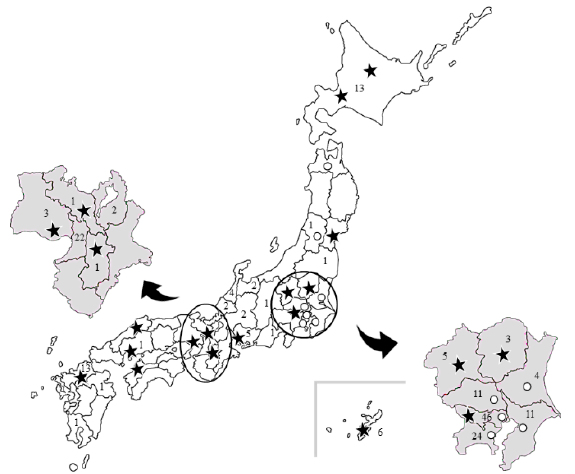
Figure 2. Distribution of ECMO coordinators and the number of patients with COVID-19 undergoing ECMO in Japan.